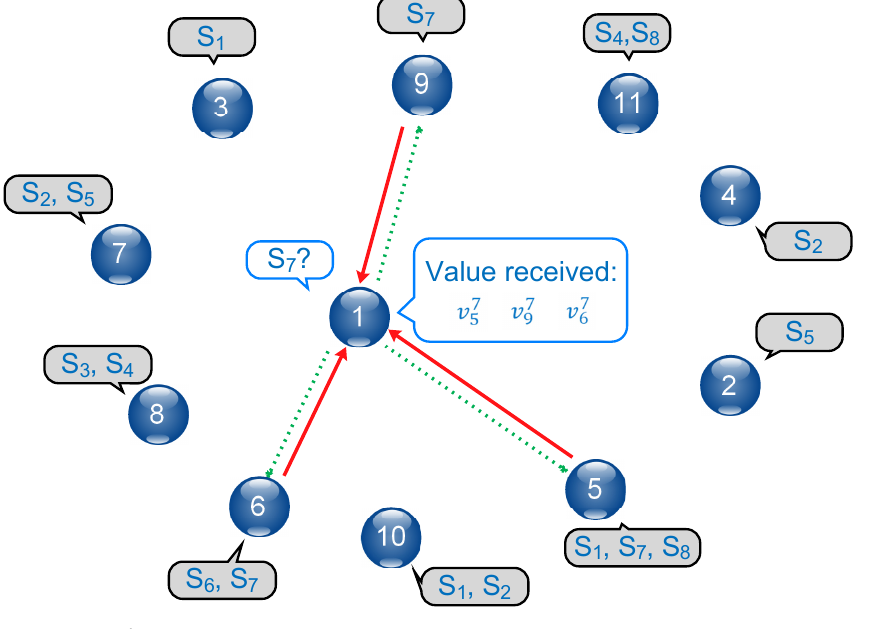
Figure 1. Reference